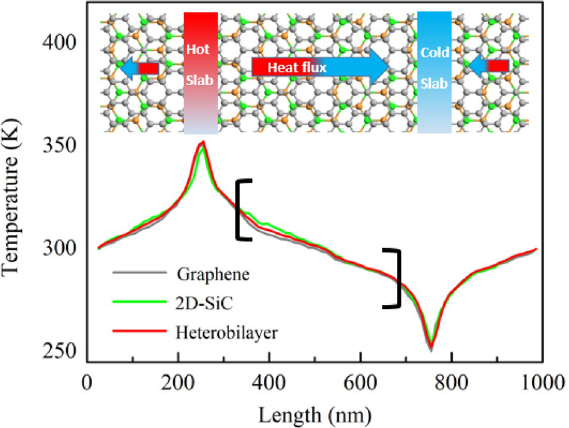
Figure 1. Atomic configuration and NEMD application procedure for the graphene/2D-SiC hetero-bilayer. Periodic boundary conditions are applied in the lateral x and y directions. Free boundary condition is used in the z direction. Temperature distributions of graphene, 2D-SiC and bilayer at steady